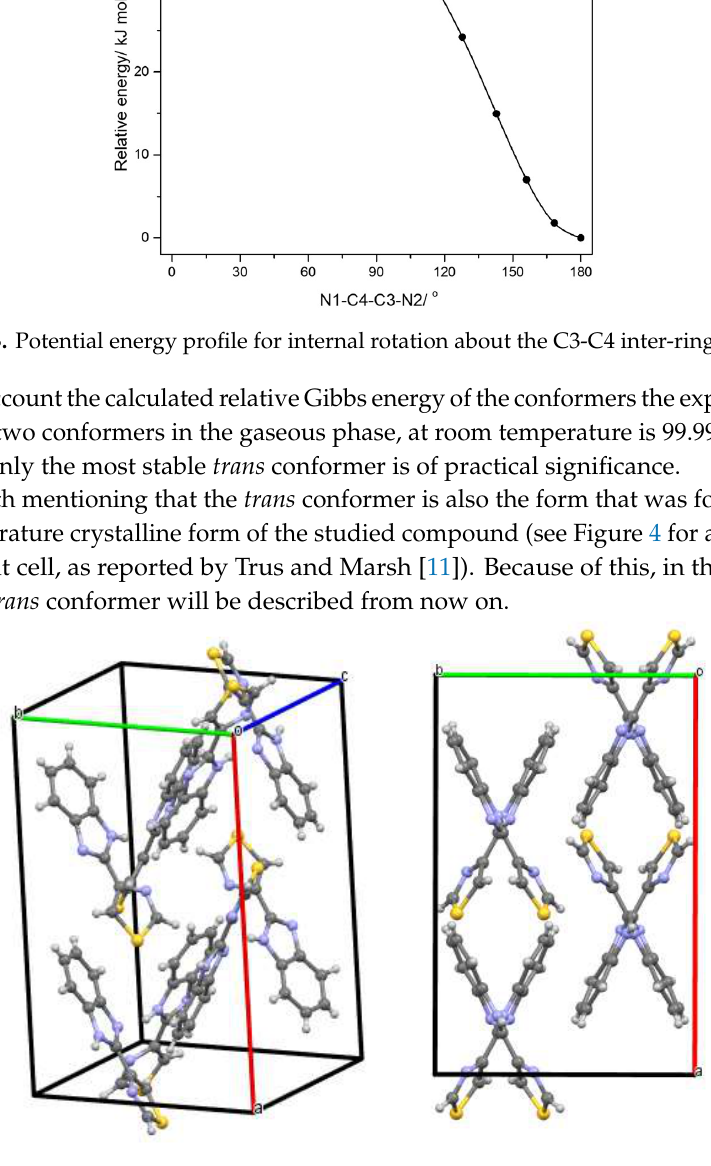
Figure 3. Potential energy profile for internal rotation about the C3-C4 inter-rings bond.